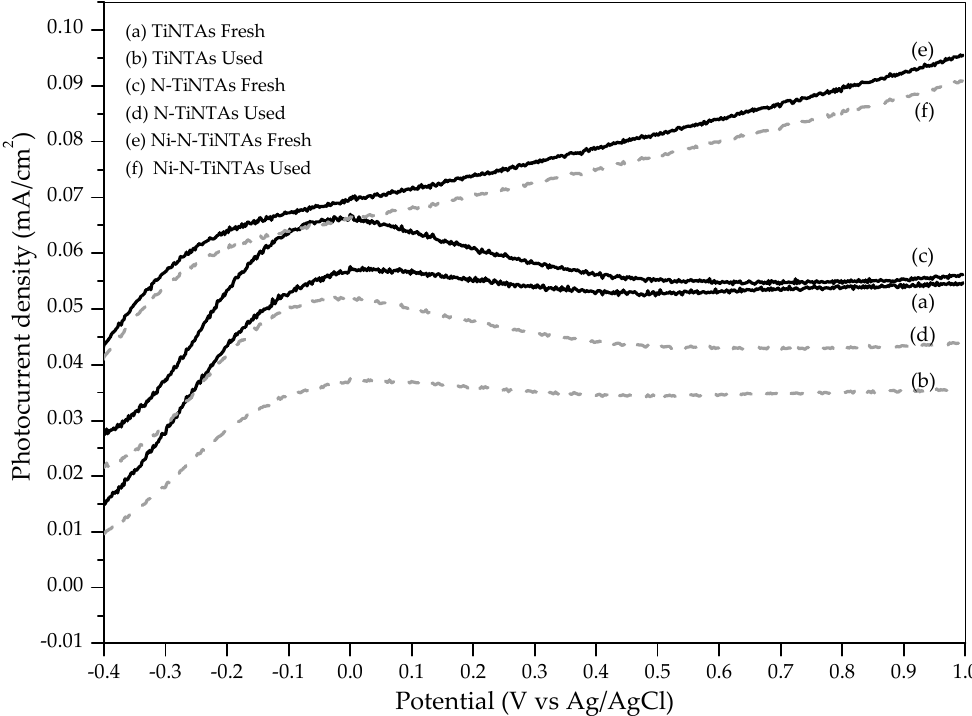
Figure 11. The photocurrent density of TiNTAs, N-TiNTAs, and Ni-N-TiNTAs in the various cycle.